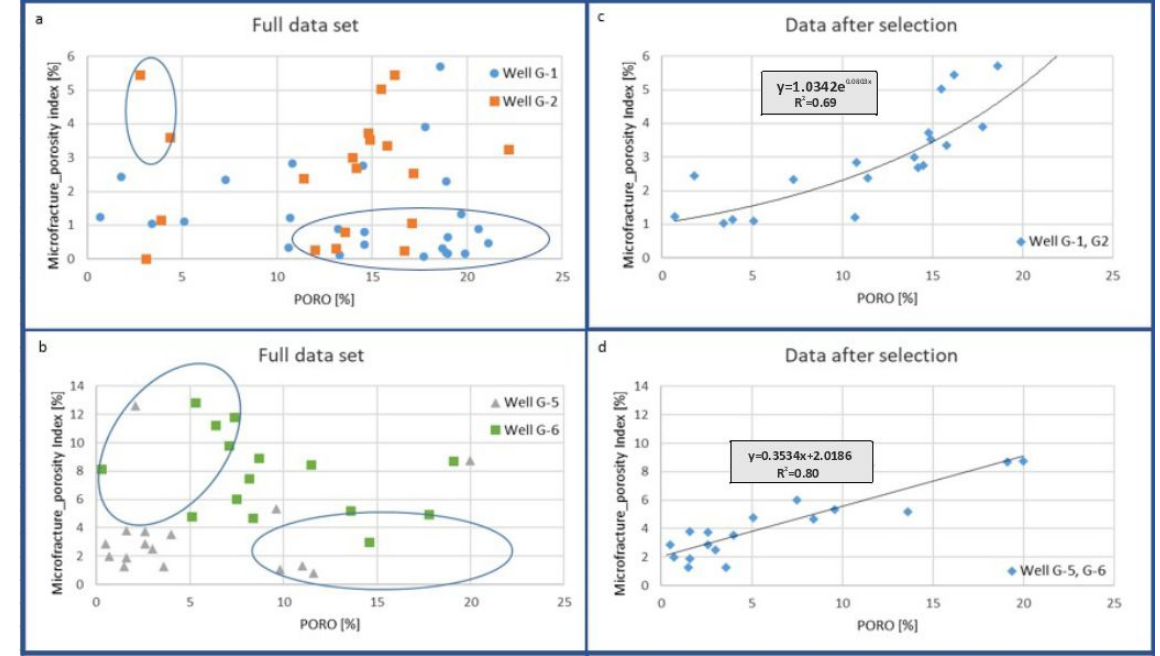
Figure 7. Microfracture_porosity Index vs. PORO: ( a ) full data set, G-1 and G-2 boreholes; ( b ) full data set, G-5 and G-6 boreholes; ( c ) data after selection, G-1 and G-2; ( d ) data after selection, G-5 and G-6.